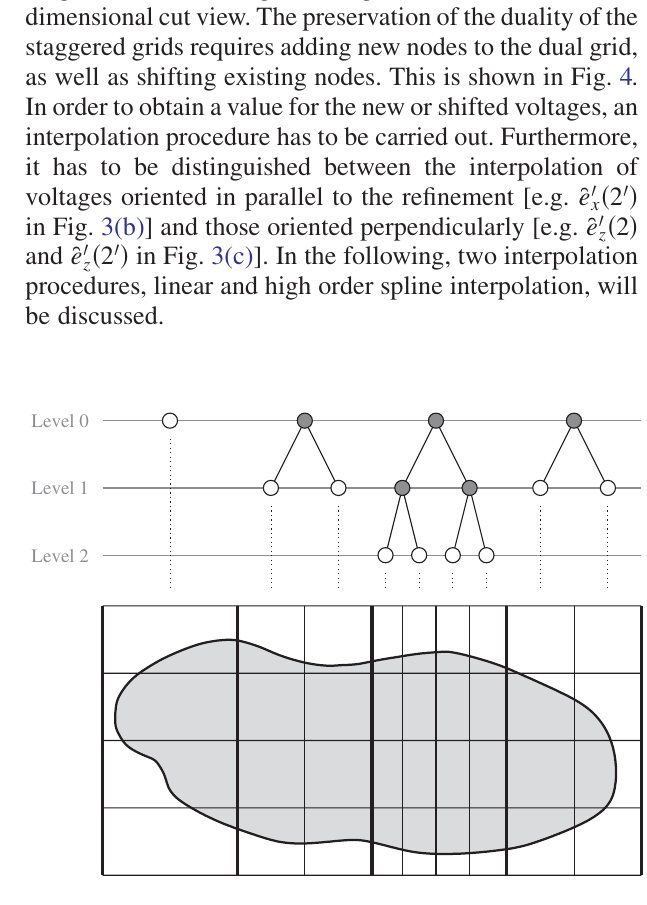
FIG. 2. Representation of the mesh refinement using consecu- tive bisections and the refinement levels. Nonrefined grid cells, such as the cells on the left end, have refinement level zero. The refinement history of a cell is recorded in a binary tree, with each bisection increasing the refinement level by one. The current grid is related to the tree leaves (white circles). Their depth in the tree reflects the refinement level L with the grid step size reducing as 1 = 2 L